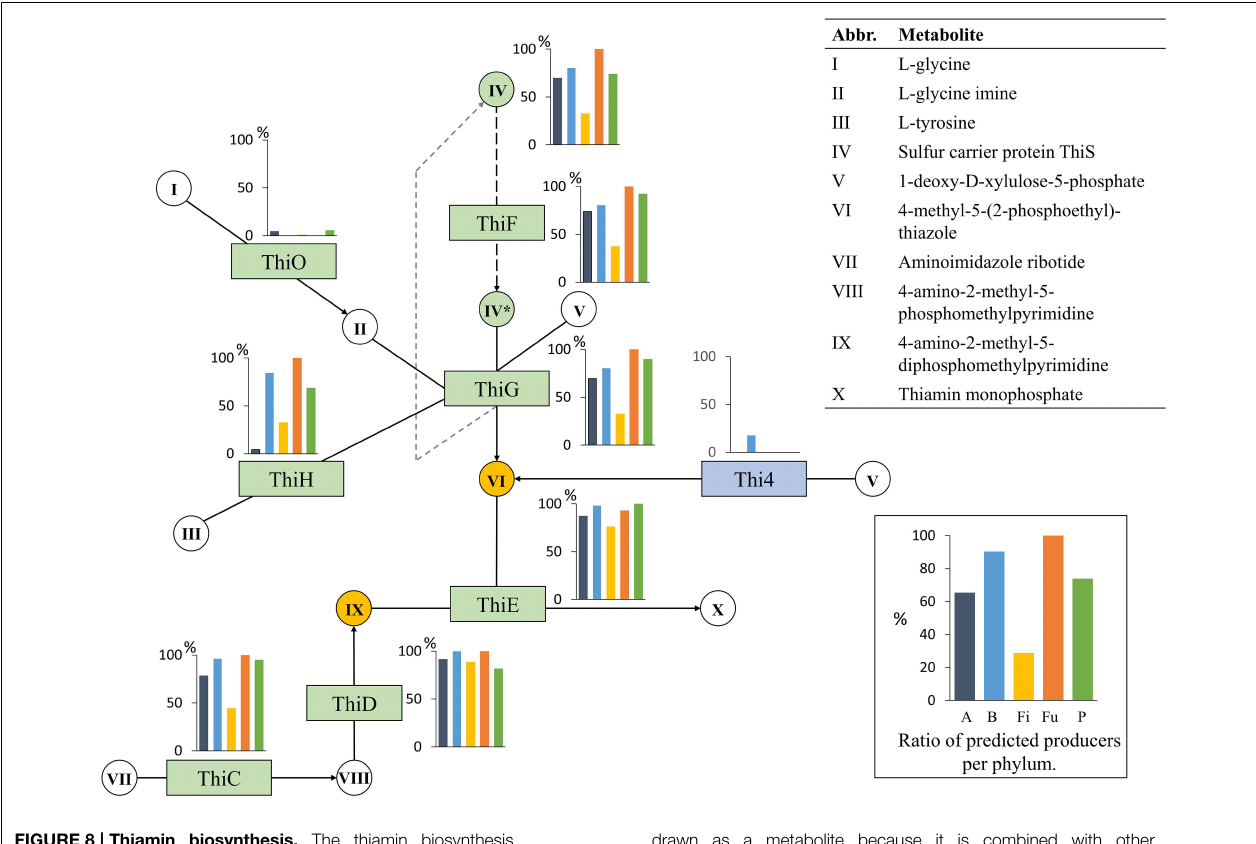
drawn as a metabolite because it is combined with other metabolites and recycled in the pathway. Refer to Figure 1 for figure